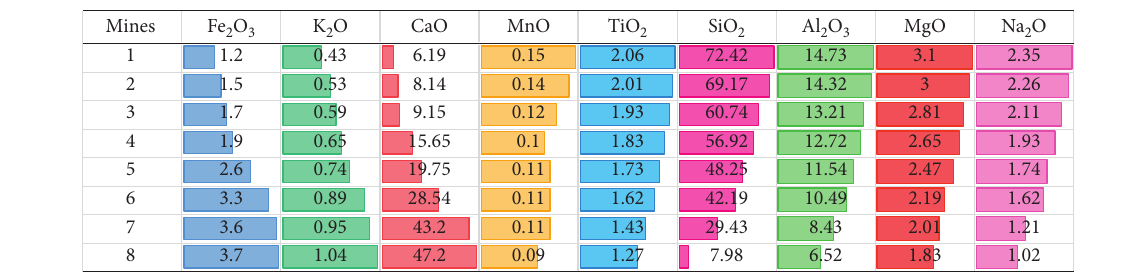
Figure 4: Results of the aggregate-forming minerals used in this study by the XRF test. Table 5: Optimal bitumen content of samples made with different aggregates.